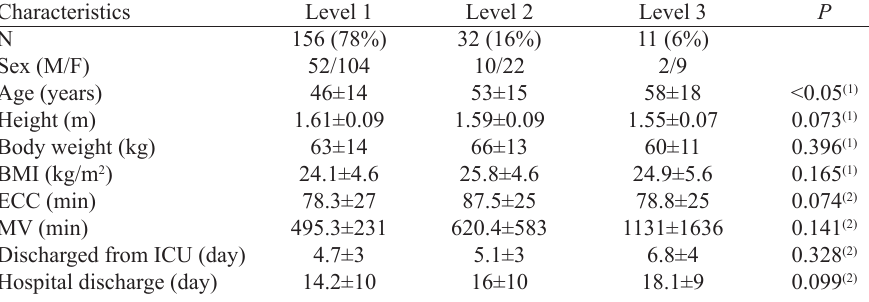
Table 2. Anthropometric characteristics and length of hospital stay of the patients classified according to level of physical assistance